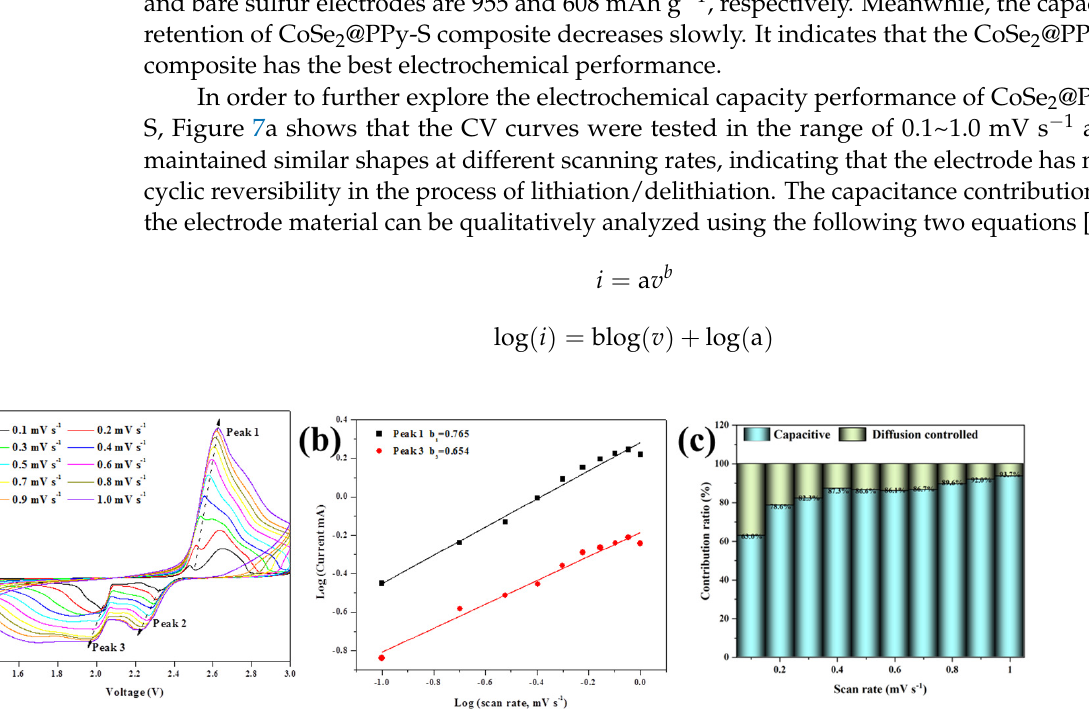
Figure 7. ( a ) CV curves of CoSe 2 @PPy-S composites at different scanning rates. ( b ) Profile of log( i ) versus log( v ) plots. ( c ) The charge contribution ratio of capacitance and diffusion at various scan